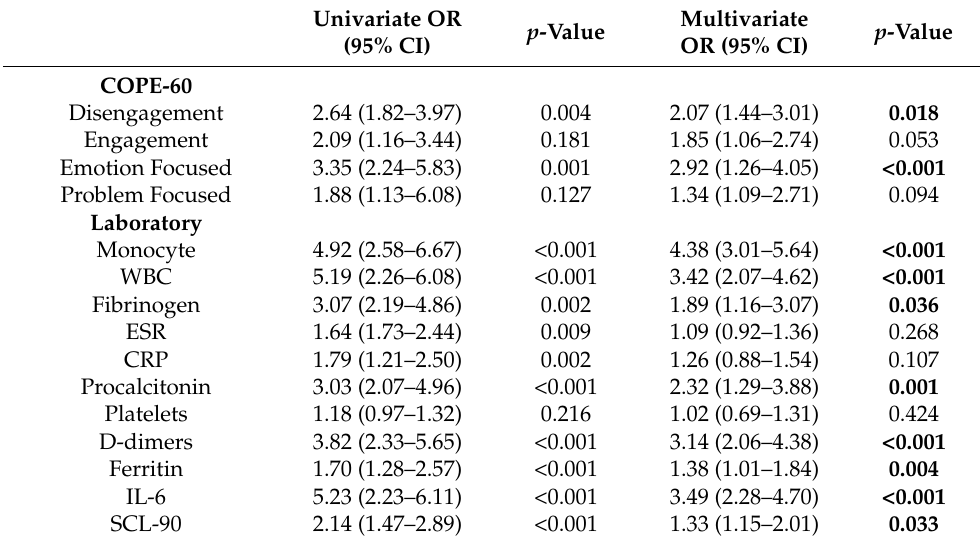
Table 7. Risk factor analysis for developing psychoticism during SARS-CoV-2